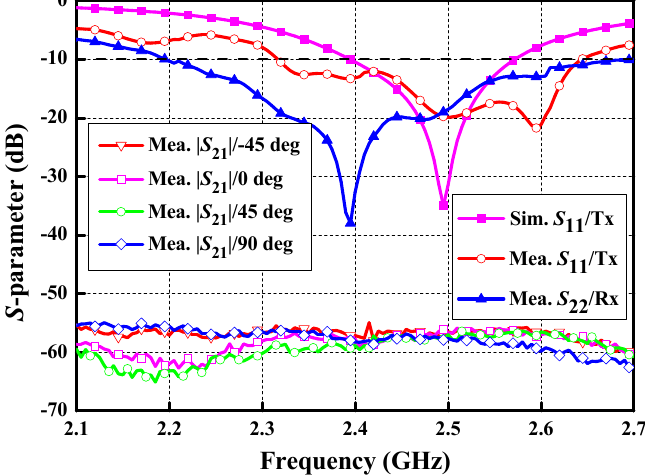
Figure 13. Measured S-parameters of the proposed antenna.